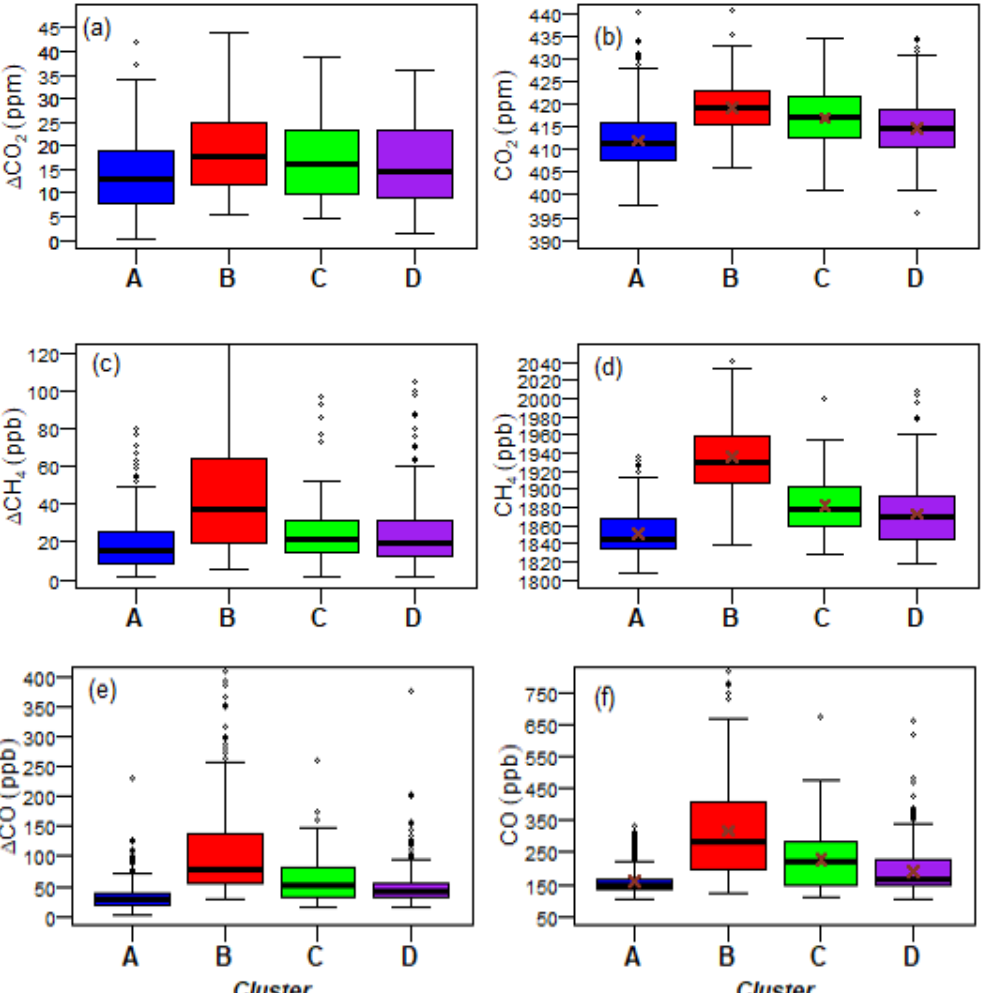
Figure 9. Average CO 2 ( a , b ), CH 4 ( c , d ), and CO ( e , f ) concentrations associated with each cluster. Box